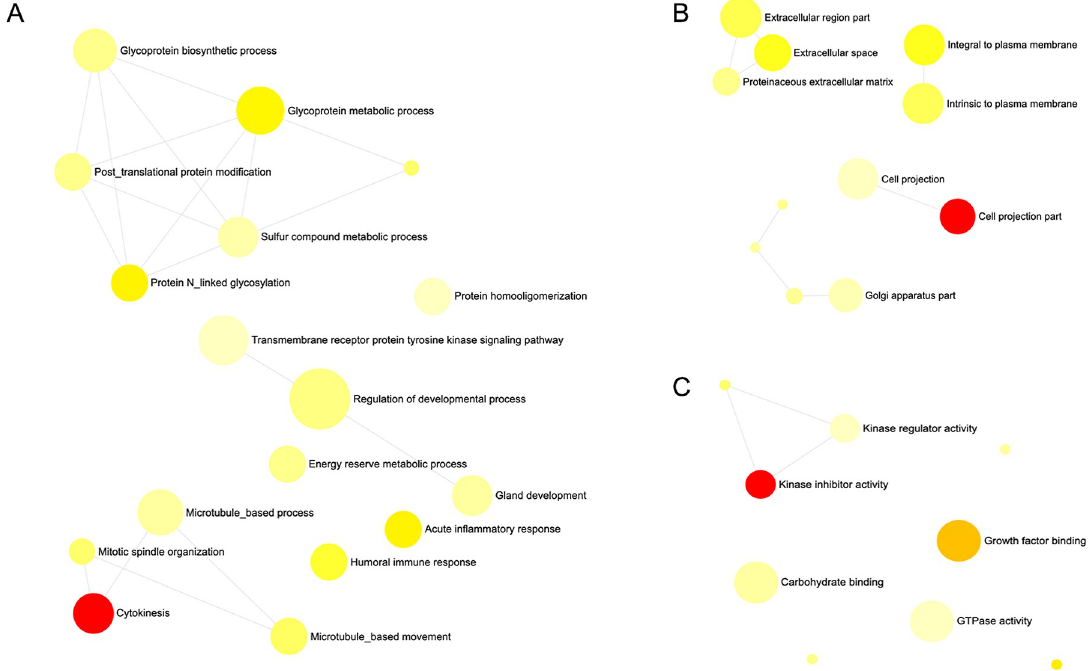
Fig 3. Network illustration of GO term enrichment classification in Javanese fat–tailed